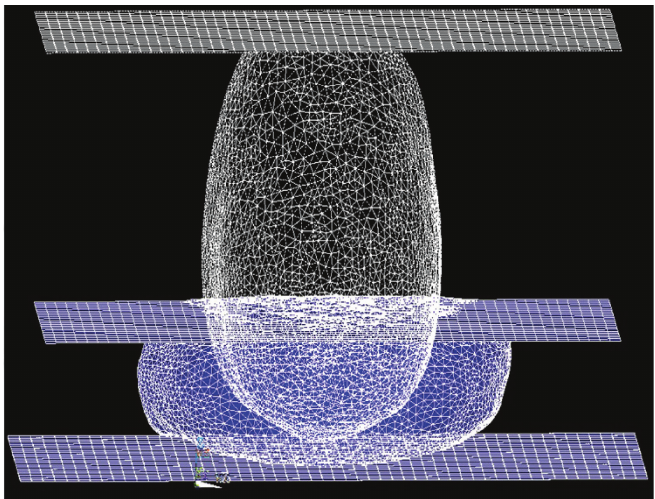
Figure 7: Mammography simulation with ANSYS.